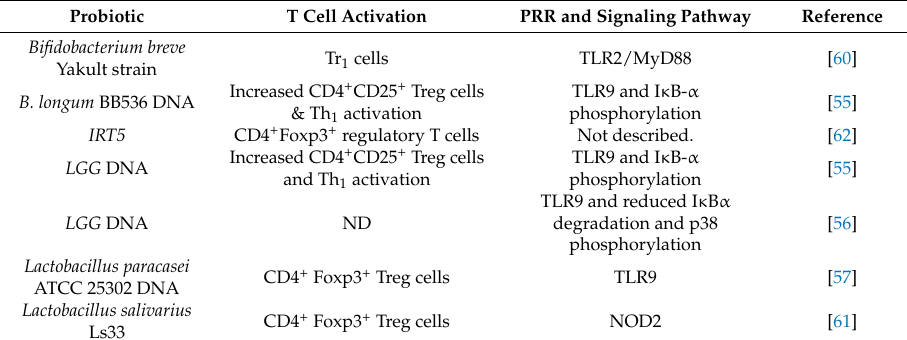
Table 2. Probiotic modulation of signaling pathways in intestinal dendritic